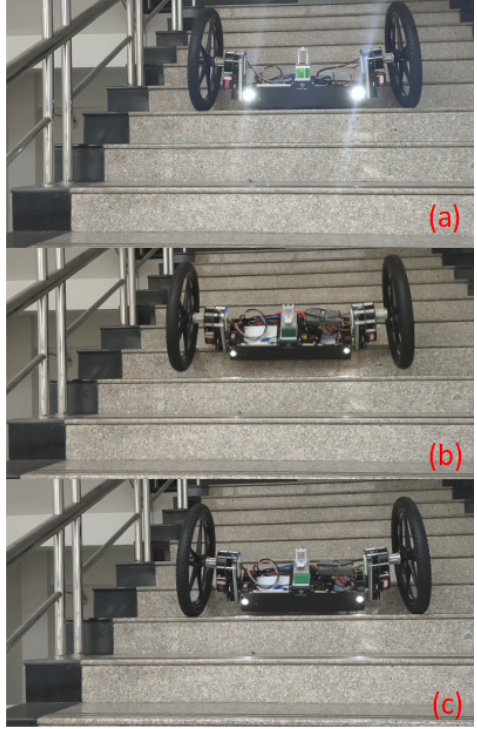
Figure 20. Experiment of the robot descending stairs: ( a ) the robot moves forward; ( b ) the body is tilted and slips down to the steps; ( c ) after the body is adjusted and stabilized, the robot continues to go downstairs.